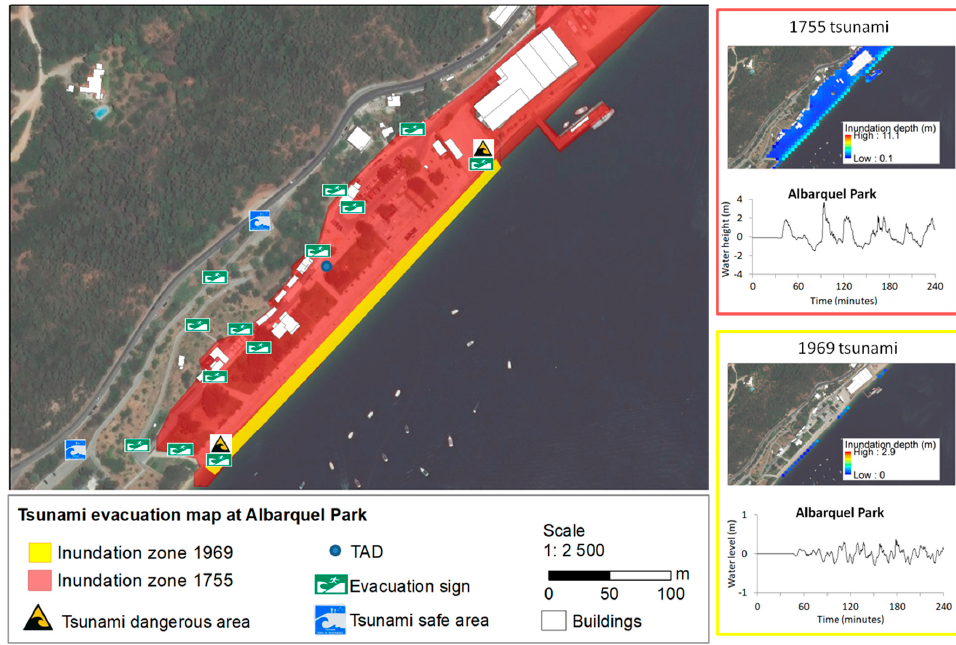
Figure 16. Details of the tsunami evacuation map at Albarquel park.